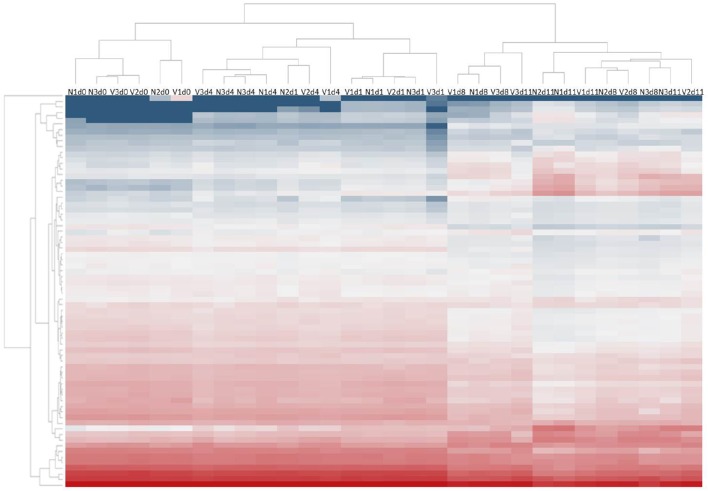
Heatmap of expression levels of miRNAs in the liver of non-vaccinated (N) and vaccinated (V) mice infected with P. chabaudi on days 0, 1, 4, 8, and 11 p.i. Expression levels for each sample were hierarchically clustered. Log2 transformed expression levels range from −4 to 14 indicated by blue and red color, respectively.